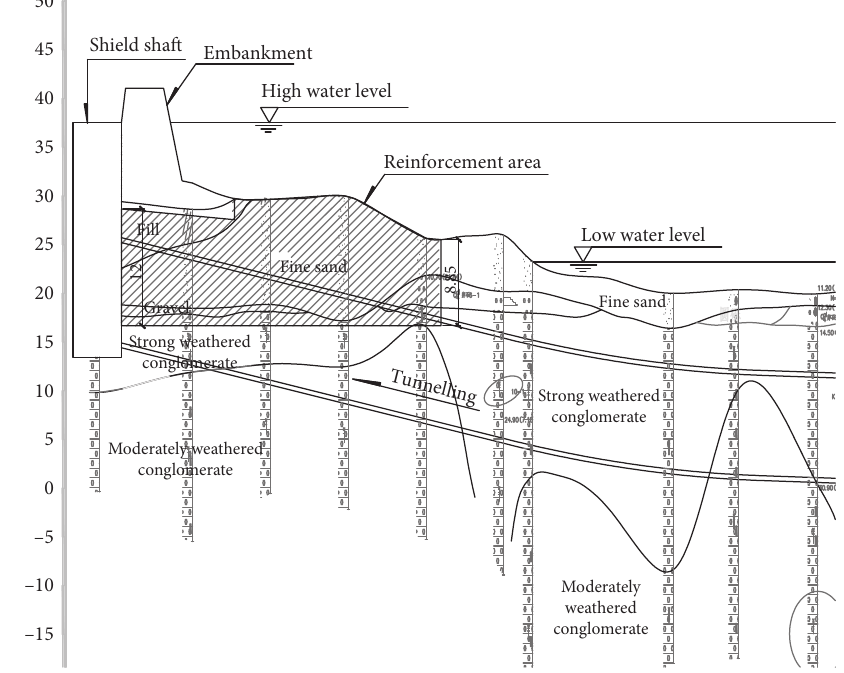
Figure 7: Longitudinal section of the grouting reinforcement area.